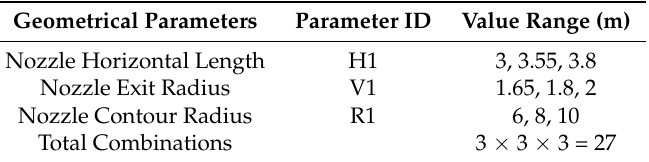
Table 4. Bell nozzle dimensional range.